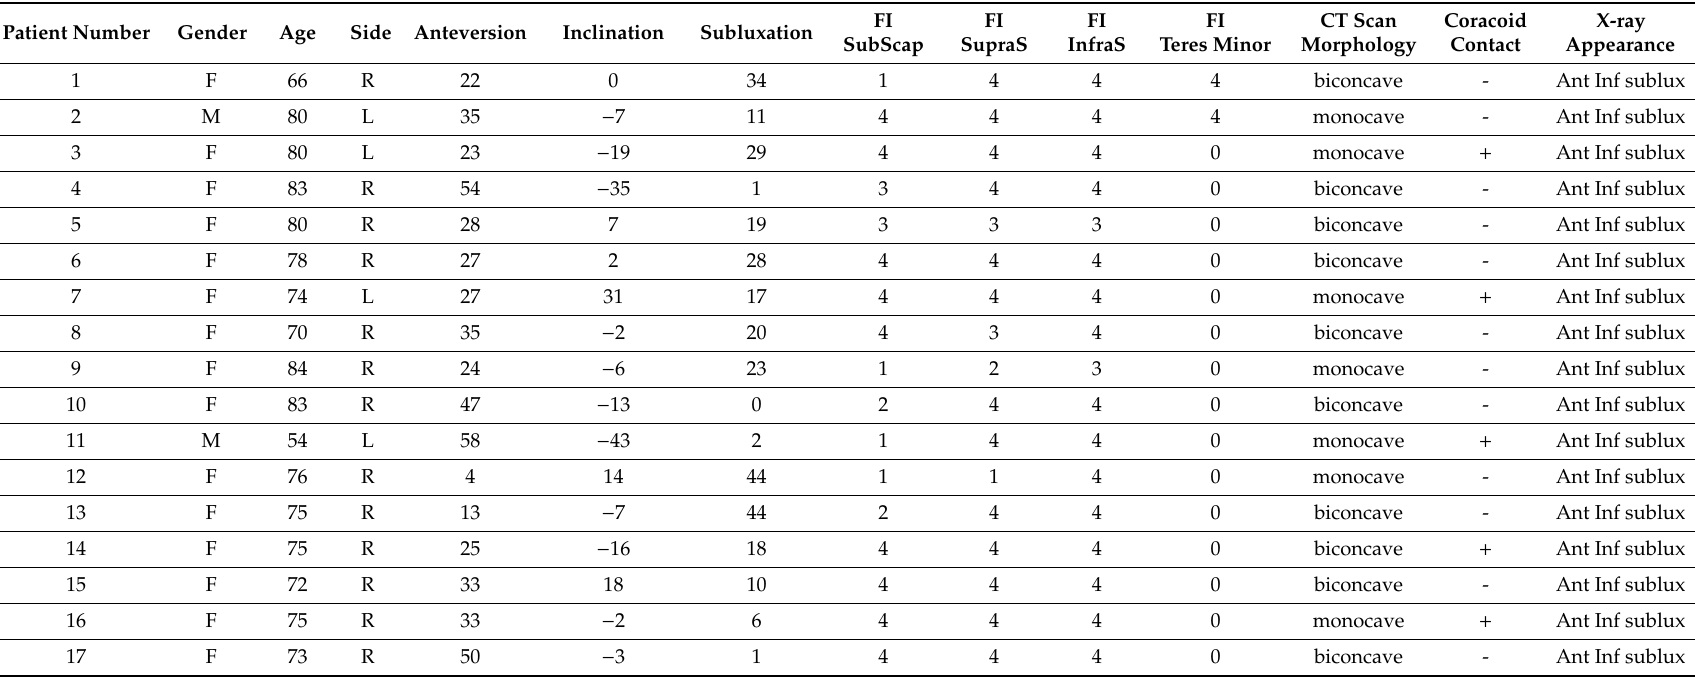
Table 1. Study cohort of 17 patients with demographics, glenoid indices, and imaging